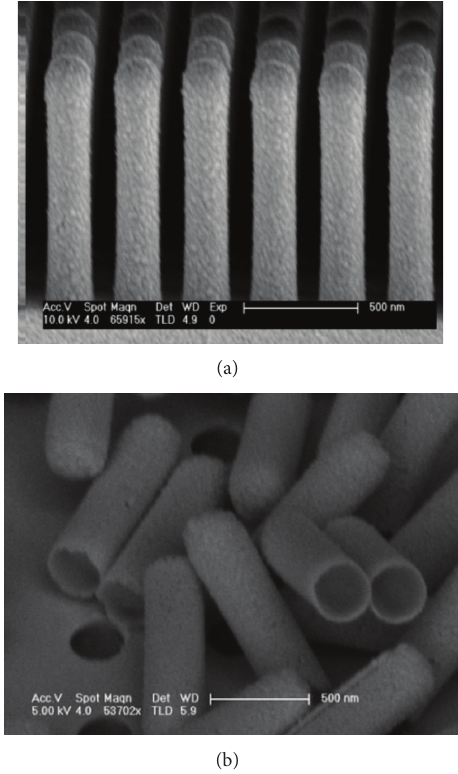
Figure 7: Nanopillars after sputter coating of 50 nm of Au, (a) pillar array, and (b) pillar array after tweezing to show the metal contacts at the